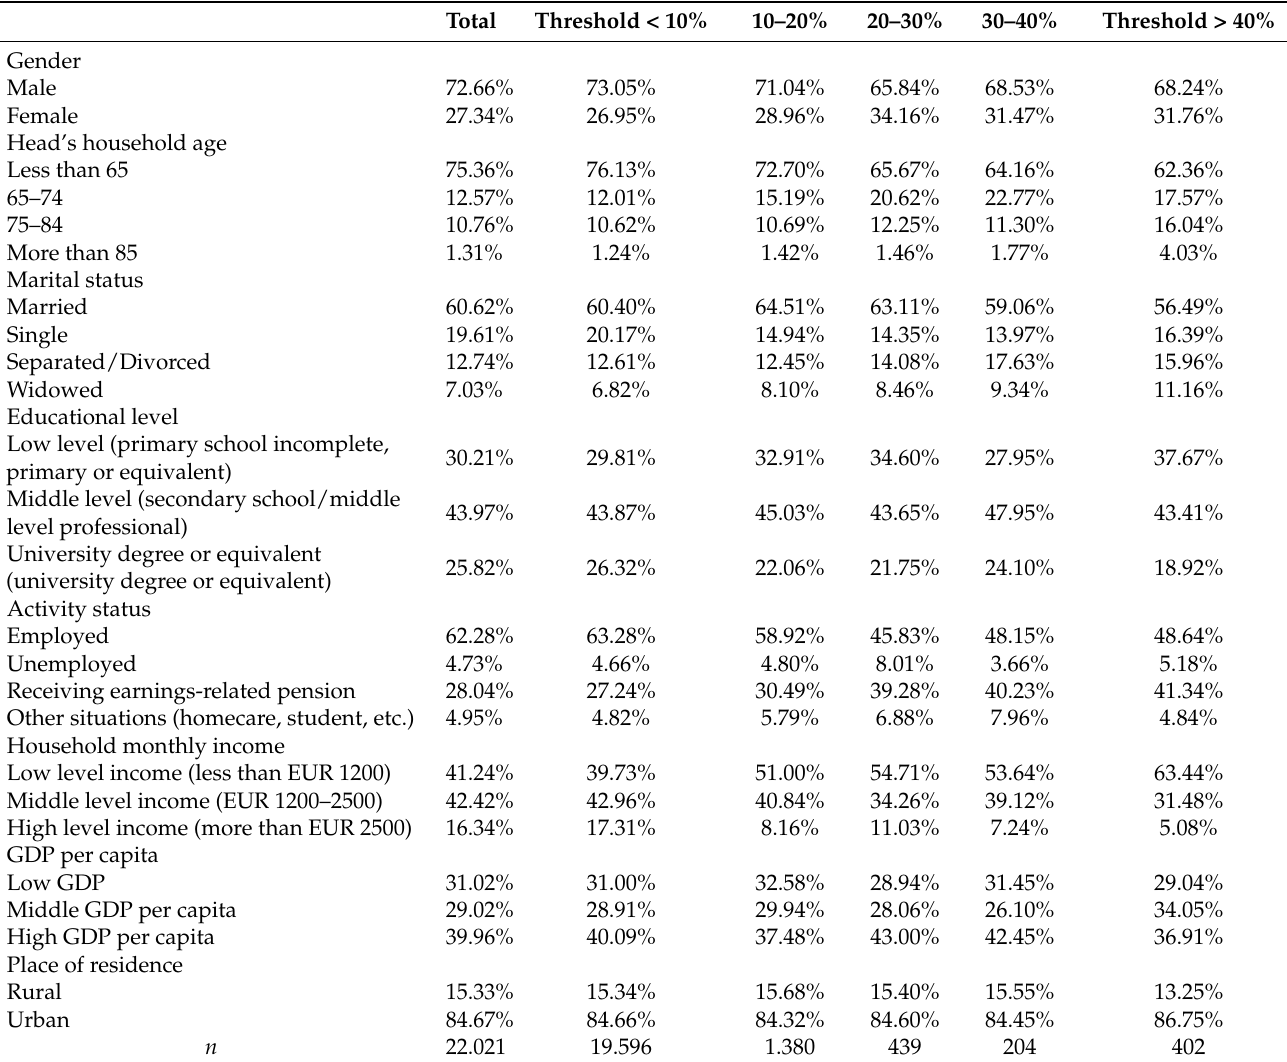
Table 1. Descriptive statistics of the sociodemographic variables of households in Spain based on the percentage of resources they dedicate to health payments. Year